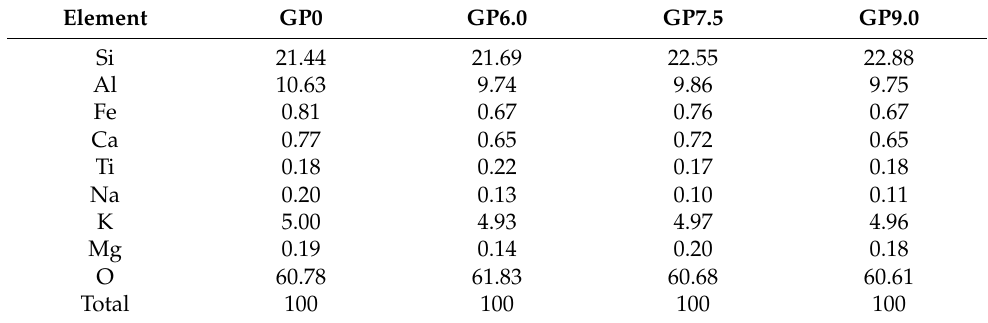
Table 6. Mean mole fraction of elements in the geopolymer pastes (EDX results from geopolymer specimens after 28 days of curing, before exposure to sulfuric